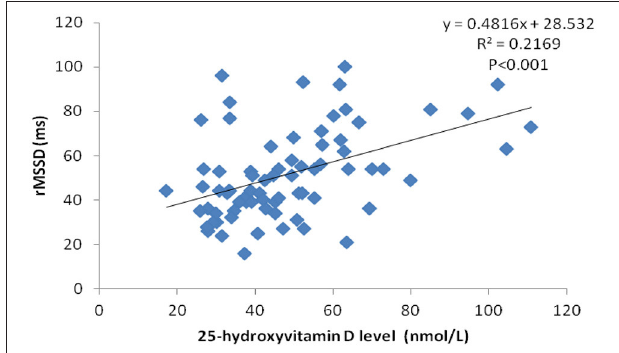
FIGURE 1 | Correlation scatter plot between serum 25-hydroxyvitamin D level and rMSSD in VVS